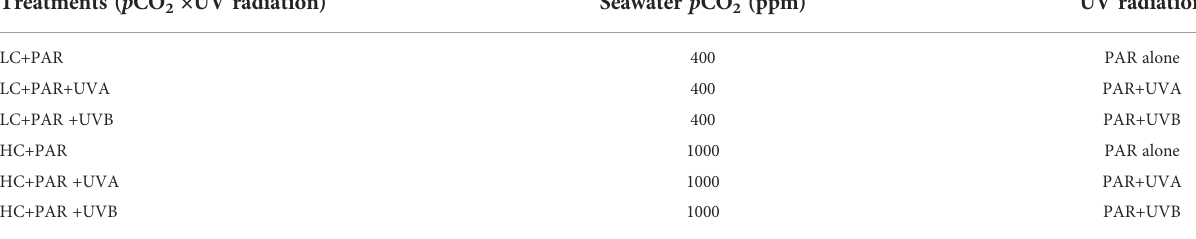
TABLE 1 2×3 factorial coupling experiments of CO 2 concentration and UV